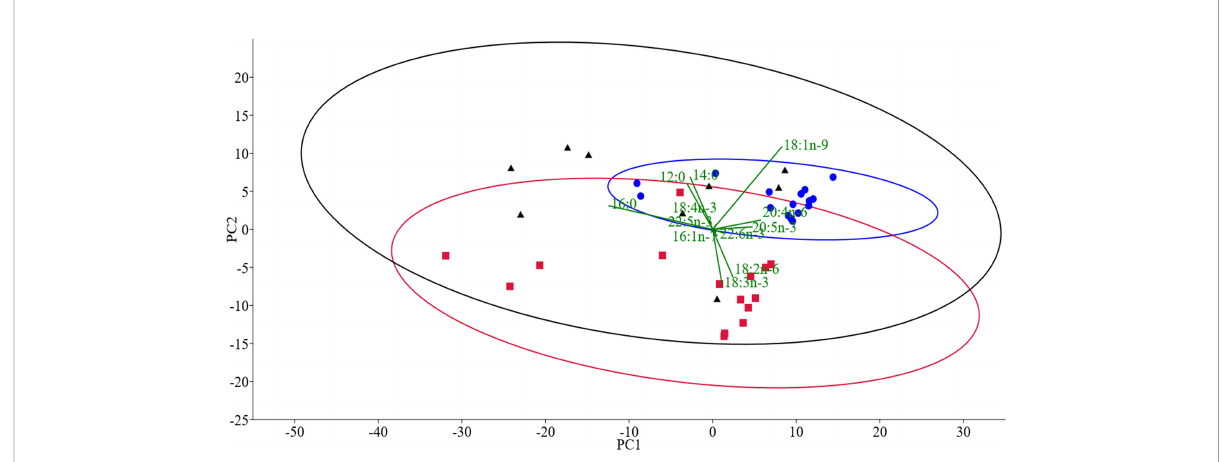
FIGURE 1 PCA of the fatty acid composition of G. locusta fed different diets and reared at different temperatures. Dots (blue), squares (red), and triangles (black) are the scores of G. locusta fed on Fucus spp., carrot leaves, and coconut, respectively. Fatty acids responsible for the grouping pattern are displayed in the biplot (green vectors); 95% con fi dence ellipses are shown. For the sake of clarity, and due to the lack of statistical signi fi cance, temperature labels are not